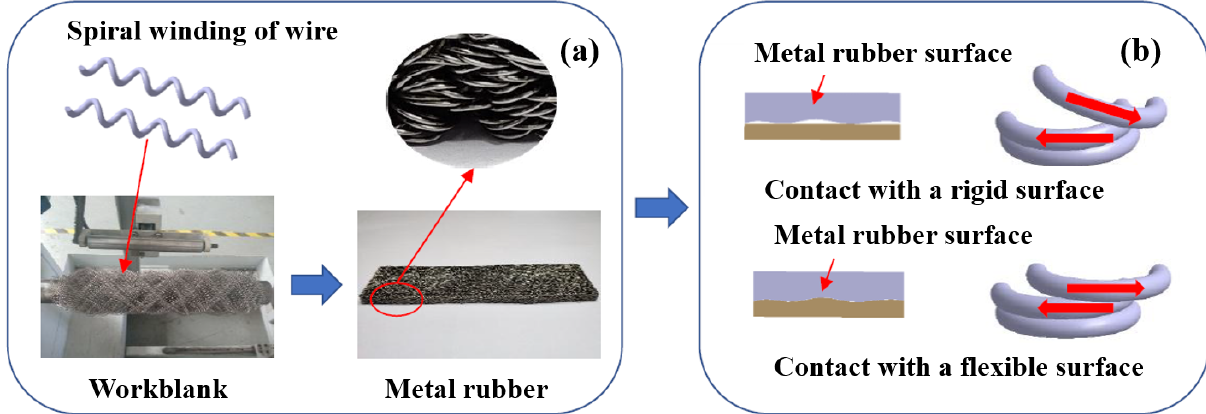
Figure 10. MR forming process and stress state of the metal wires contacting a rigid and a flexible surface, respectively: ( a ) MR forming process; ( b ) Contacting state.